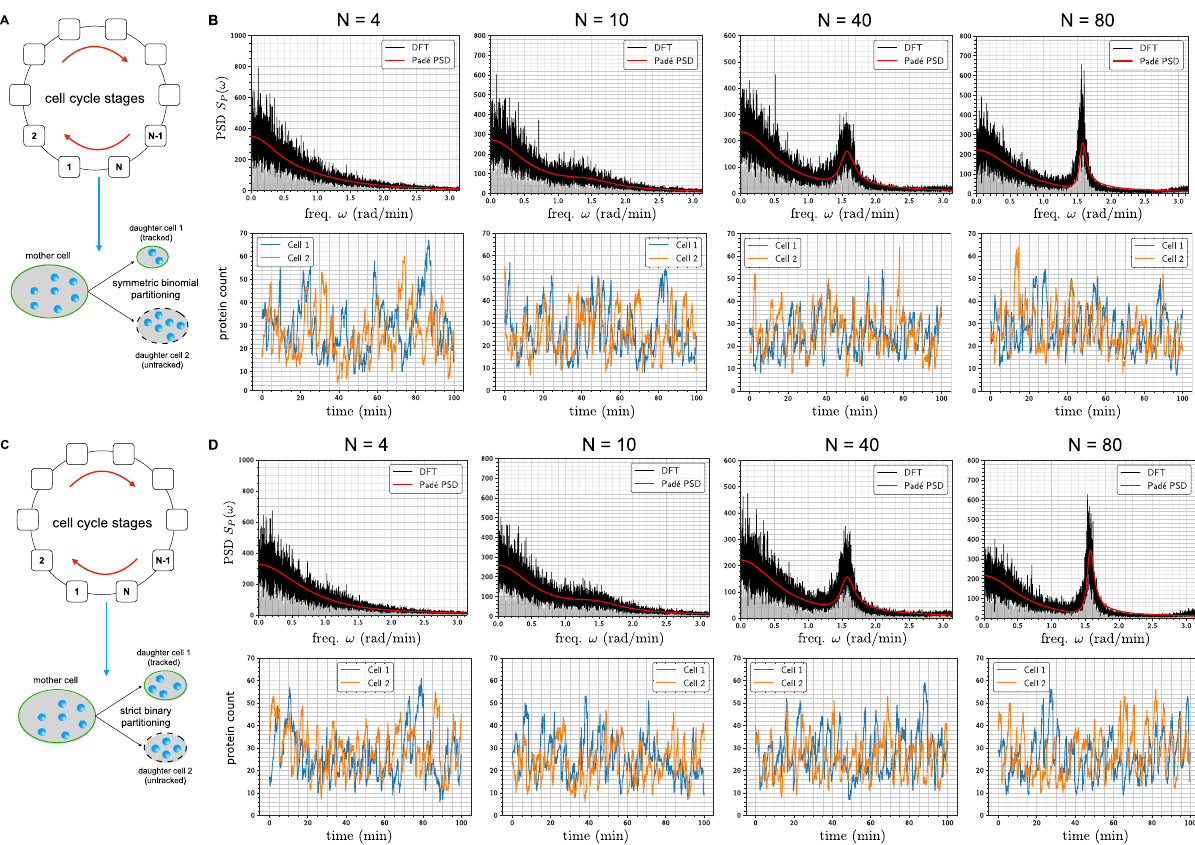
Fig. 7 Cell-cycle induced oscillation in gene expression. We model the cell-cycle evolution as a N -stage Markov process with a constant rate α of transitioning from one stage in the cycle to the next. When the transition is from state N to state 1, the mother cell splits into two daughter cells, from which only one cell is tracked and measured. At the time of the split, the mother cell molecules are partitioned in one of two ways — symmetric binomial (i.e. each molecule has a 50% chance of ending up in the tracked cell) and strict binary (i.e. the tracked cell receives exactly half of the molecules of each network species). These two scenarios are depicted in panels ( A ) and ( C ). In panel B (resp. panel ( D )), we suppose that the cell undergoing symmetric binomial (resp. strict binary) partitioning, contains the gene expression network shown in Fig. 2A. We plot the single-cell trajectories for the protein counts as well as the corresponding PSDs estimated with the Padé PSD and the DFT methods for four values of the cell-cycle length N , keeping the cell-cycle frequency constant. All the PSDs were estimated with Q = 10 simulated